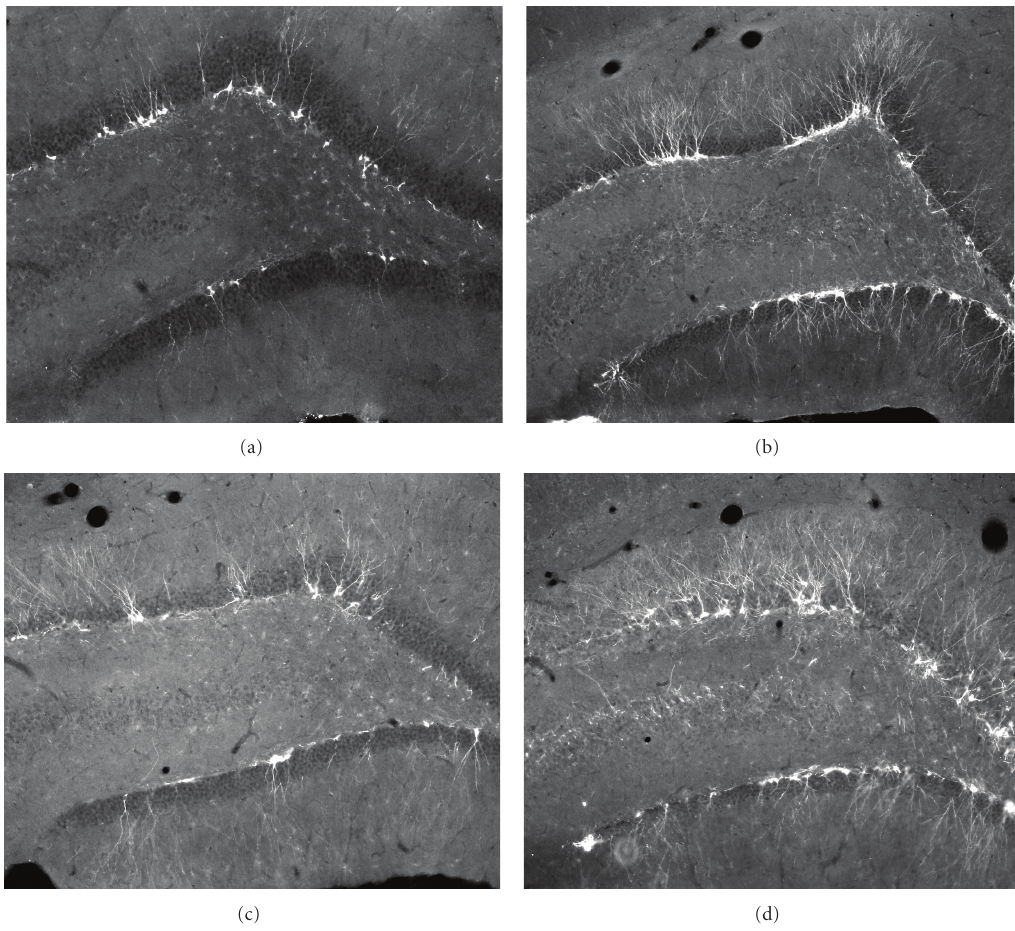
Figure 5: Regardless of adrenalectomy (ADX), the combined enrichment and exercise treatment significantly increased neurogenesis as indexed by doublecortin (DCX). Representative pictures of DCX positive cells in the dentate gyrus of (a) home cage controls, (b) controls exposed to wheel running and enrichment, (c) ADX rats housed in the home cage, and (d) ADX rats exposed to wheel running and